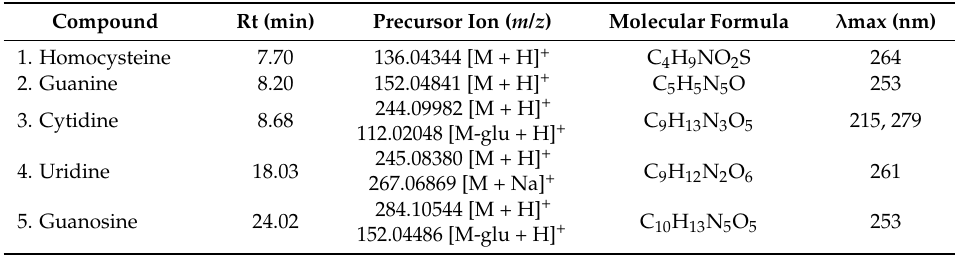
Table 1. Retention time (Rt), precursor ion, molecule formula, and ultraviolet maxima ( λ max) of peaks identified in ethanol extract of P. americana Mill.